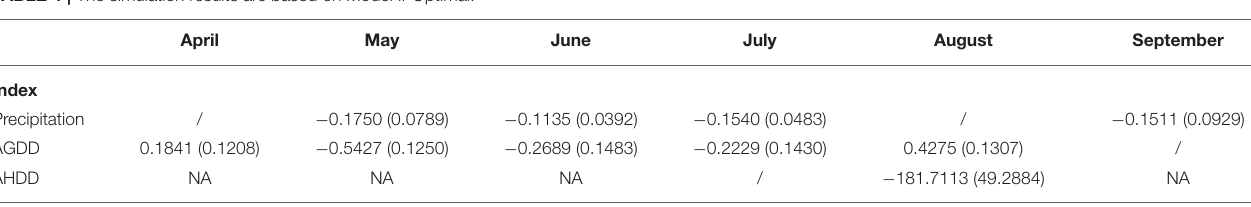
TABLE 4 | The simulation results are based on Model